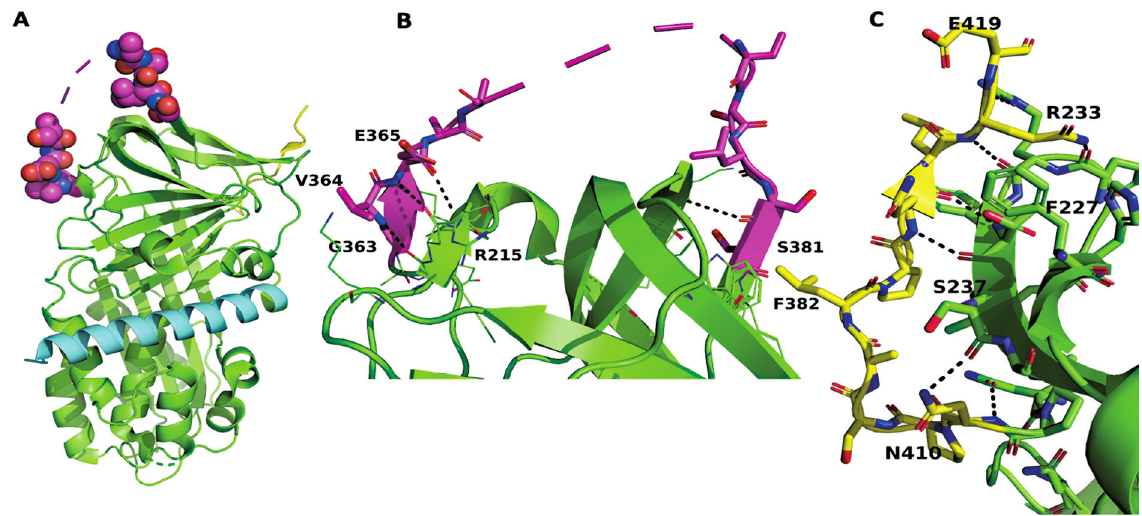
Fig.3 Crystal structure of murine PI. ( A ) Overall topologyof murine PI with the N terminus shownincyan, reactive center loop in magenta, andC terminus in yellow. ( B ) Close up of the reactive center loop ( magenta ) showing the N-terminus portion (363 – 365) making several hydrogen bonding interactions ( black dashed lines ) with residues 214 – 216 of the main body of PI ( green, selected residues labeled ). The C-terminal portion (residues 380 – 382) makes a speci fi c hydrogen bonding interaction with residue K306 on the fi rst strand of the C-sheet. ( C ) Close up of the contacts between the C-terminal region ( yellow ) and the main body of PI ( green ). Several hydrogen bonds are made between the two parts of the protein ( black dashed lines ); selected residues are labeled. Source: Law et al. 14